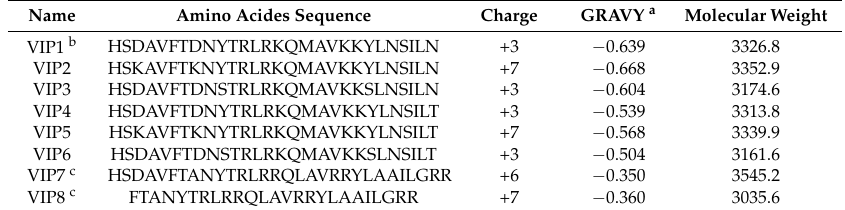
Table 1. Sequences and structural properties of VIP and the VIP